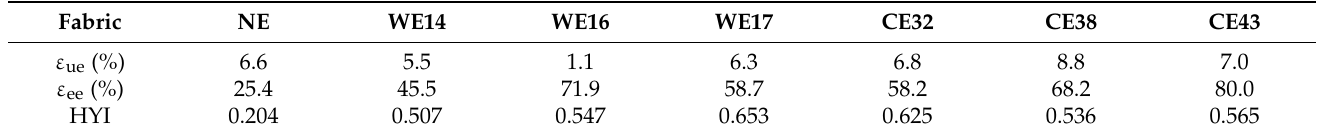
Table 7. Unrecovered elongation ( ε ue ), elastic elongation ( ε ee ), hysteresis index (HYI) in the 5th cycle in the course